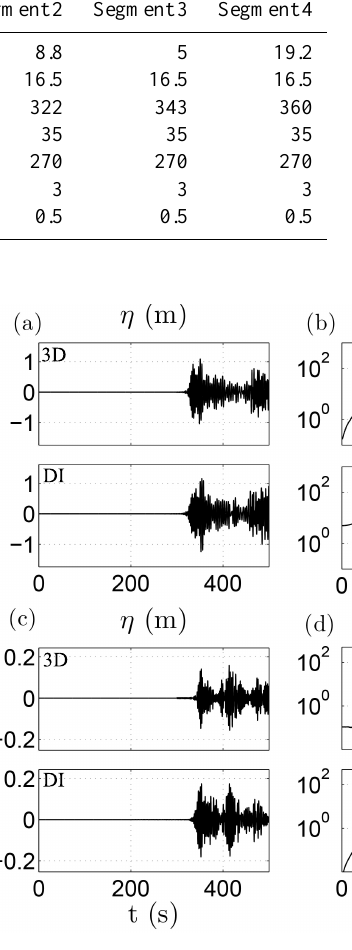
frequency spectra (right column) at the CTS point ( a and b ) and CP point ( c and d ). Comparison between the solution of the 3-D ref- erence model (upper plots) and the solution of the depth-integrated equation (lower